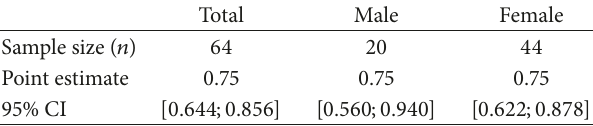
Table 3: Percentage of accurate results.